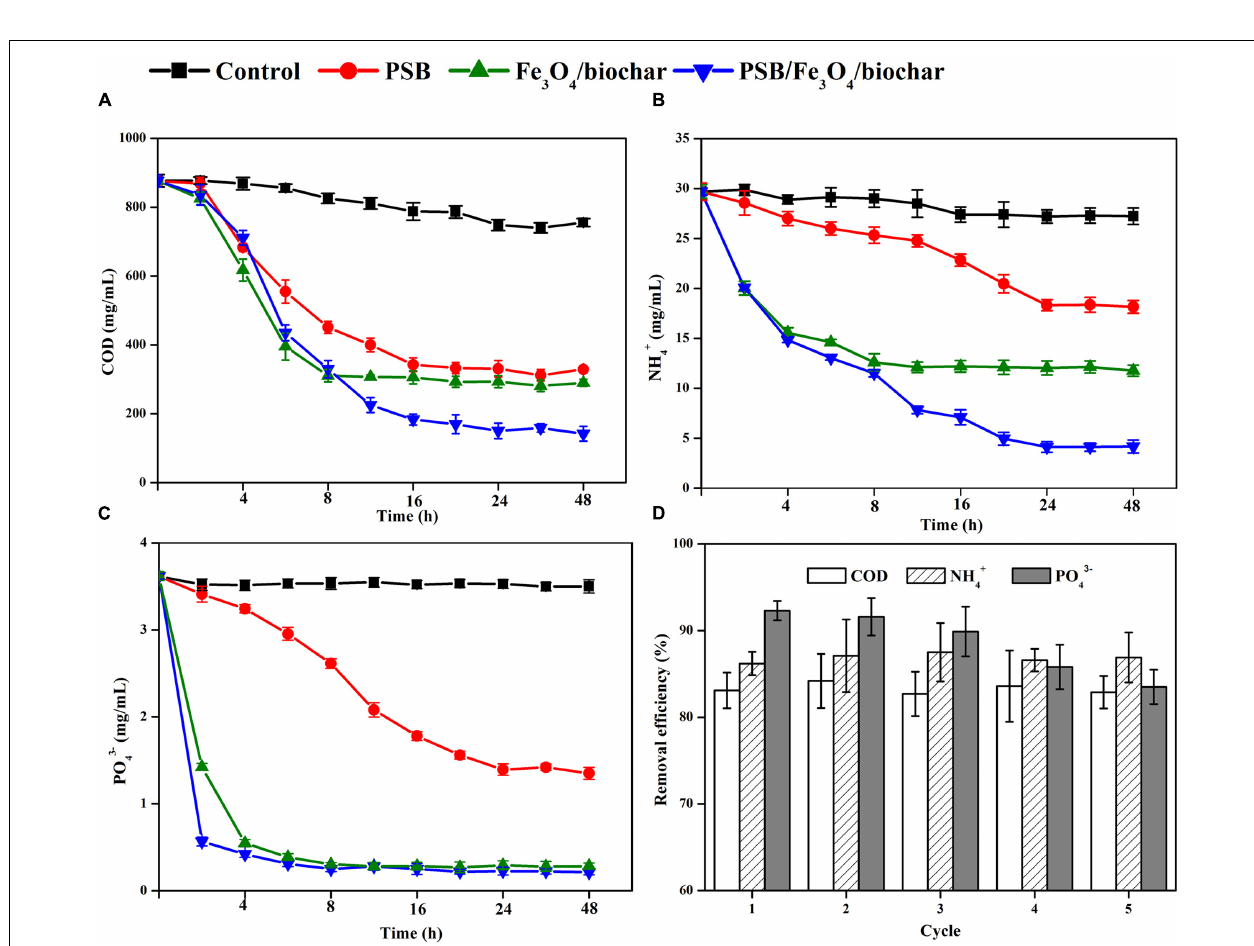
FIGURE 5 | Removal of (A) COD, (B) NH + 4 , and (C) PO 3 − 4 (by PSB, Fe 3 O 4 /biochar, and PSB/Fe 3 O 4 /biochar). (D) Nutrient removal ability of PSB/Fe 3 O 4 /biochar during five cycles.